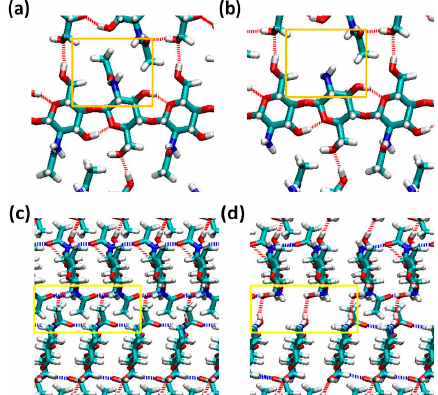
Figure 1. H-bonds formed within each model along the inter-chain direction ( a , b ) and inter-sheet direction ( c , d ). The orange and yellow boxes highlight the difference in H-bond pattern along inter-chain and inter-sheet directions respectively. The dashed lines stand for H-bonds and the color represents the acceptor atom. ( a , c ) are the H-bond formation for a chitin molecule; ( b , d ) are H-bond formed for a chitosan molecule. Comparing ( a , b ), we note that the acetyl group does not contribute to the formation of H-bond linking inter-chain direction. Comparing between ( c , d ), we note that the molecule without an acetyl group does not form the blue H-bonds linking inter-sheet direction.